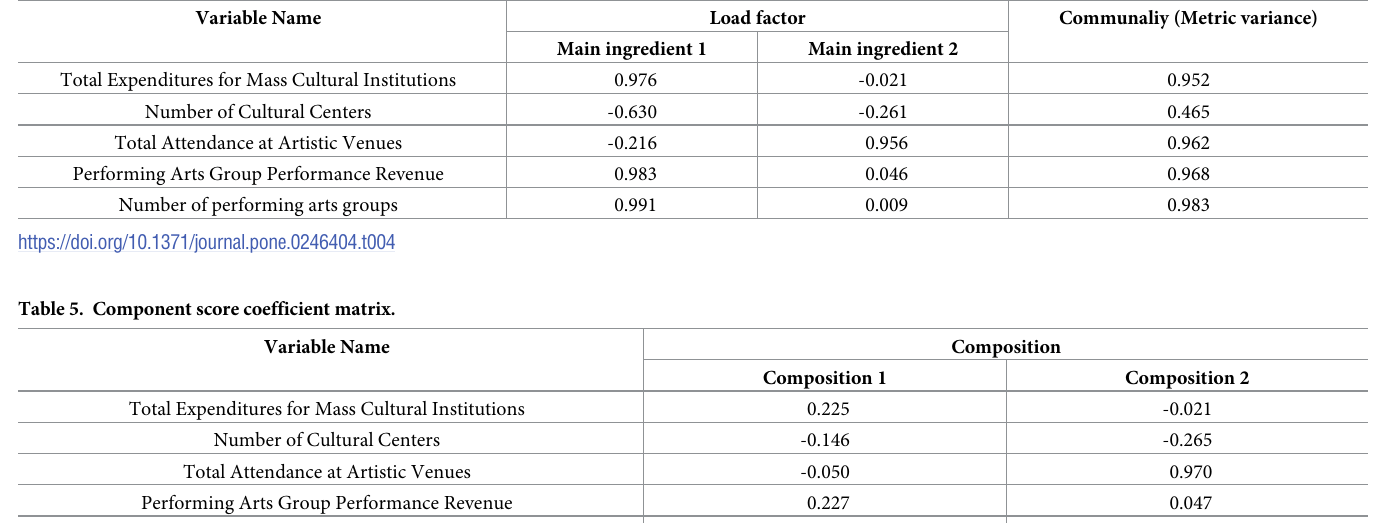
Table 4. Table of principal component load factors.